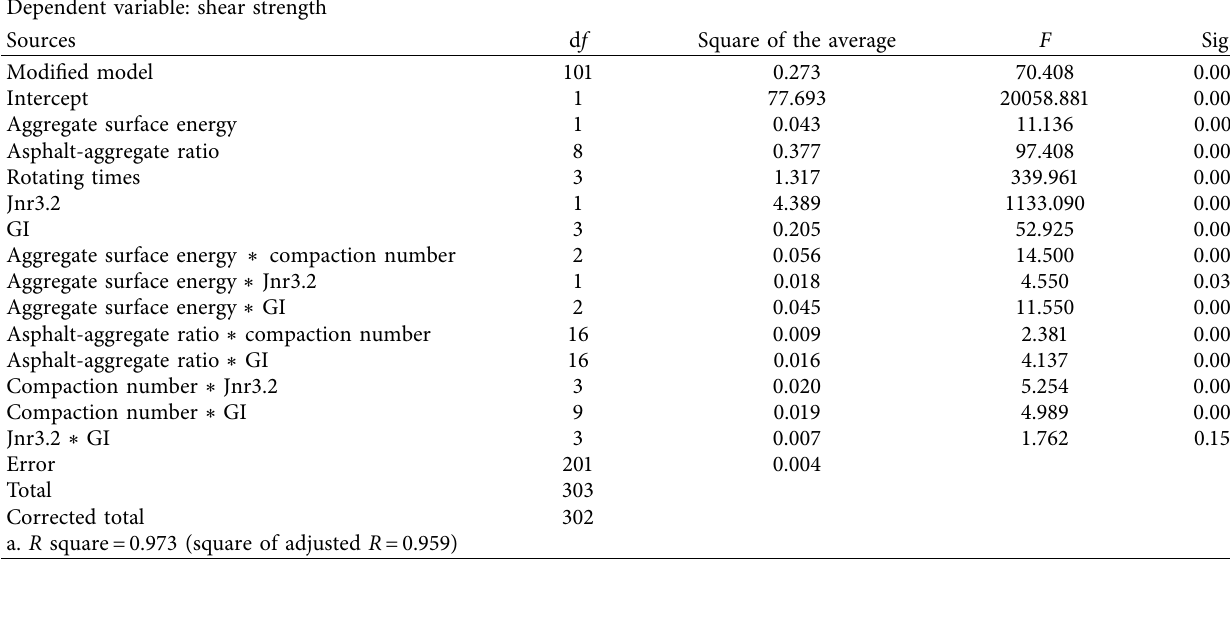
Table 5: ANOVA results with the test